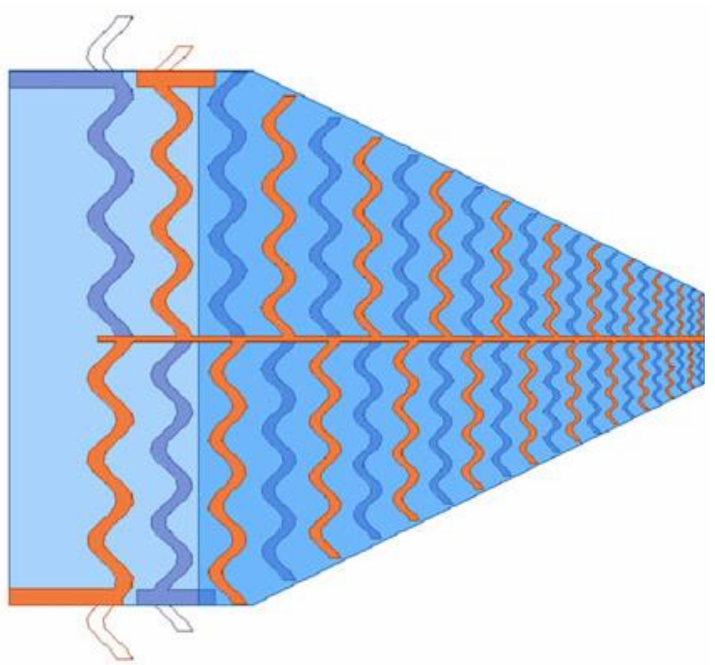
Figure 8. PLPDA design with dielectric-loading technique